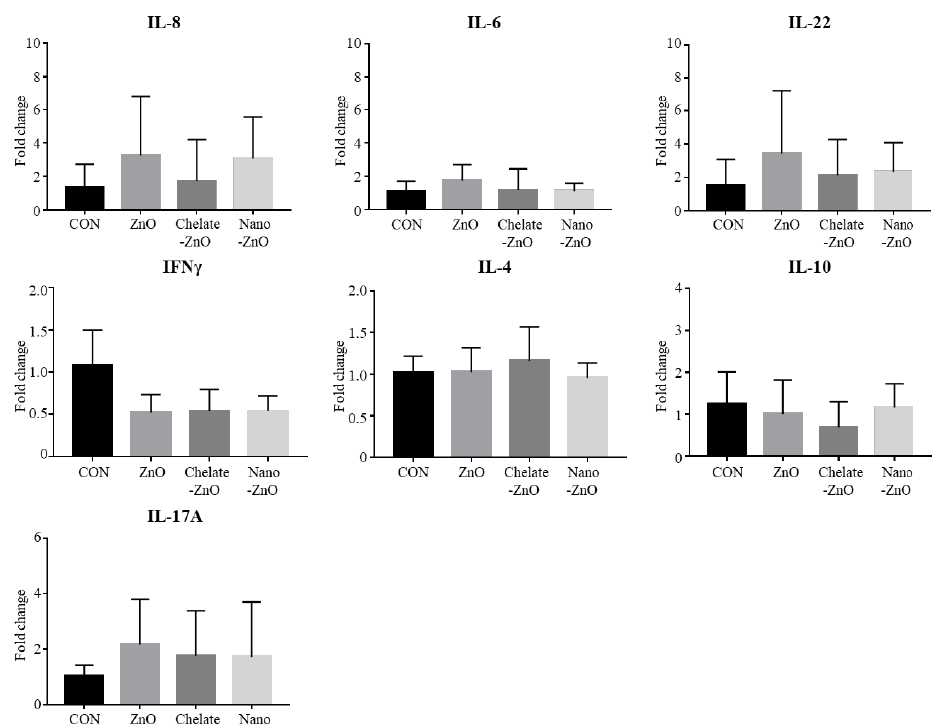
Figure 5. Major cytokine expression in the mesenteric lymph nodes (MLN) of weaned piglets fed different forms of zinc oxide. IL-8, IL-6, IL-22, IFN γ , IL-4, IL-10, and IL-17A gene expressions in the MLN were examined in piglets weaned on different forms of zinc oxide by using qRT-PCR. MLN cells were stimulated with 5 ug/mL of LPS for four hours on 37 °C and 5% CO 2 condition. mRNA expression levels of the cytokines in each group were calculated based on that of the negative control group (CON). All fold change values were normalized by GAPDH. Data are represented as mean ± SD. Values were statistically analyzed by one-way ANOVA with Tukey ’ s multiple comparison test.